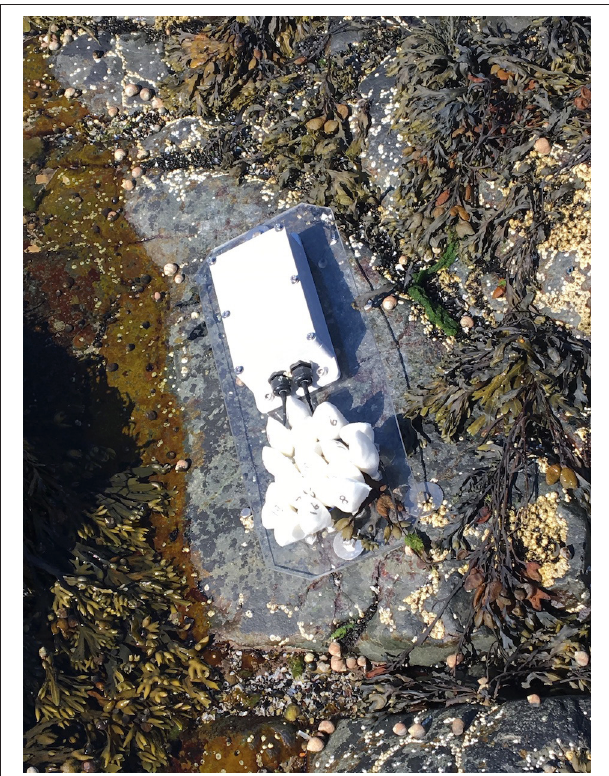
FIGURE 7 | A robomussel bed prototype deployed in the rocky intertidal zone in Nahant, MA USA. The robomussels in this prototype are colored white in order to collect preliminary data on how albedo may affect the accuracy of biomimetic